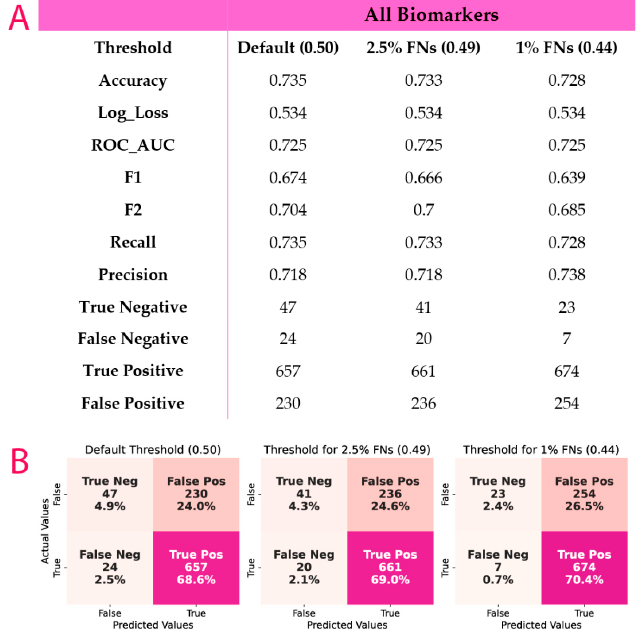
Figure 3. ( A ) Probability threshold and all quality metrics for the CorLipid algorithm. ( B ) Confusion matrices for true false positive and negative for the model with different false negative thresholds. FNs: false negative predictions, expressed as a percentage of the sum of FN and TP, FNs = FN/FN + TP).